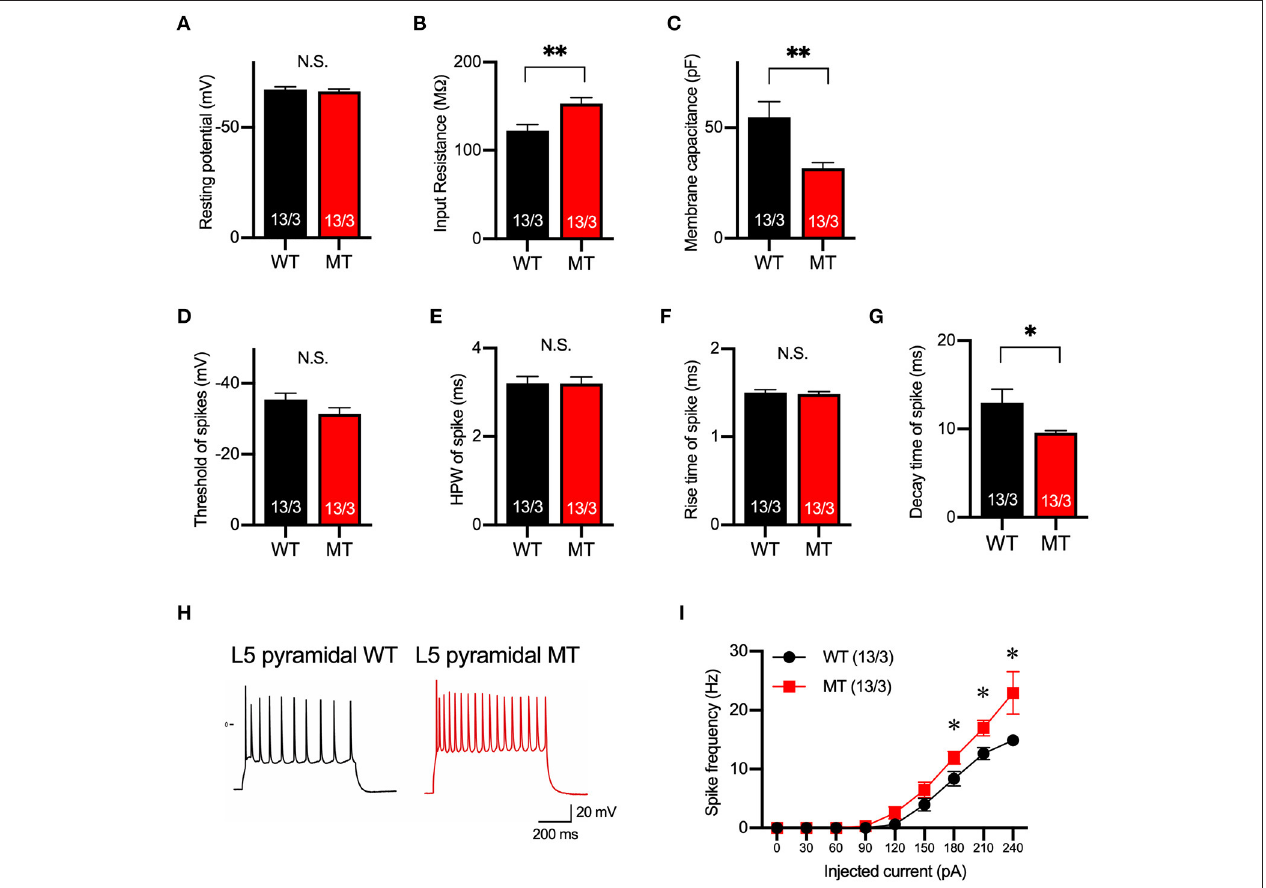
FIGURE 2 | Membrane and firing properties were changed in pyramidal neurons in layer 5 of the mPFC. (A–C) Resting membrane potential (A) , input resistance (B) , membrane capacitance (C) of pyramidal neurons in layer 5 of mPFC of SIK1-WT or -MT mice. (D–G) threshold (D) , half-peak width (E) , rise time (F) , and decay time (G) of the action potential of the pyramidal neurons in layer 5 of the mPFC. (H) Representative traces of induced action potentials responded to 240pA injected currents. (I) Graph for the relationship between spike frequency and injected current. Input resistance and spike frequency of action potential were increased, and membrane capacitance and decay time of action potential were decreased in SIK1-MT mice. The numbers of neurons and mice used in each analysis are shown on the bar (neurons/mice) in the graphs. Statistical analysis was made by Student’s t -test. Statistical significance was indicated by asterisks (* p < 0.05 and ** p <